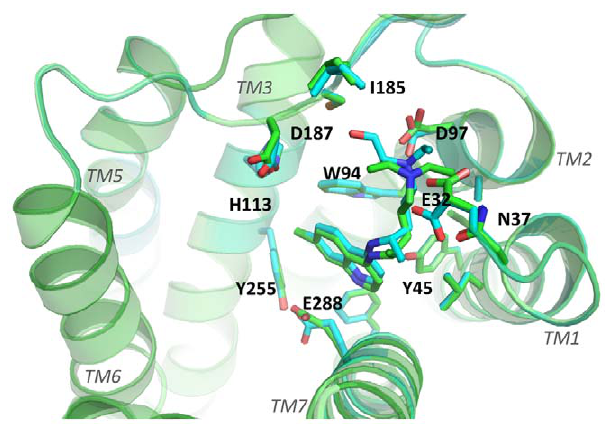
Figure 8. Top view of the predicted ligand binding site in the crystal structure of human CXCR4. Green helices, TM1, 2, 3, 5, 6, and 7 are shown. Upon binding, both chloroquine and hydroxychlor- oquine interact favorably with the indicated residues (E32, N37, Y45, W94, D97, H113, I185, D187, Y255, E288) shown in sticks. These residues are within 5 A˚ of the bound compound. However, the amino acid residues at the CXCR4 binding site are oriented slightly different depending on whether chloroquine or hydroxychloroquine bind. The relative orientations of the CXCR4 amino acid residues that interact with chloroquine and hydroxychloroquine are shown as green and cyan sticks, respectively.